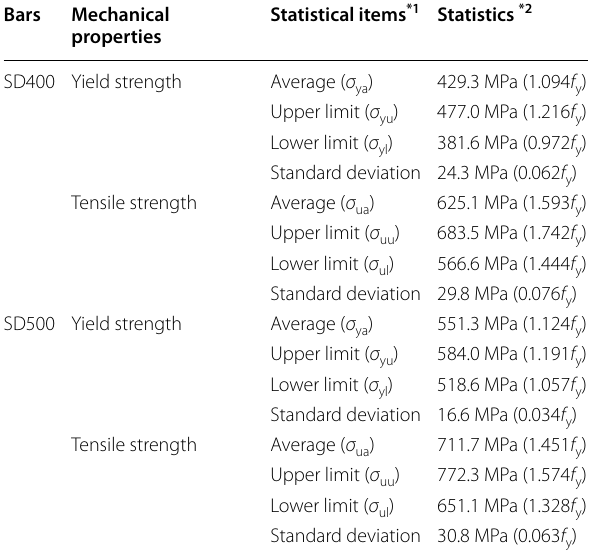
Table 2 Statistical data for the tensile strength and yield strength of